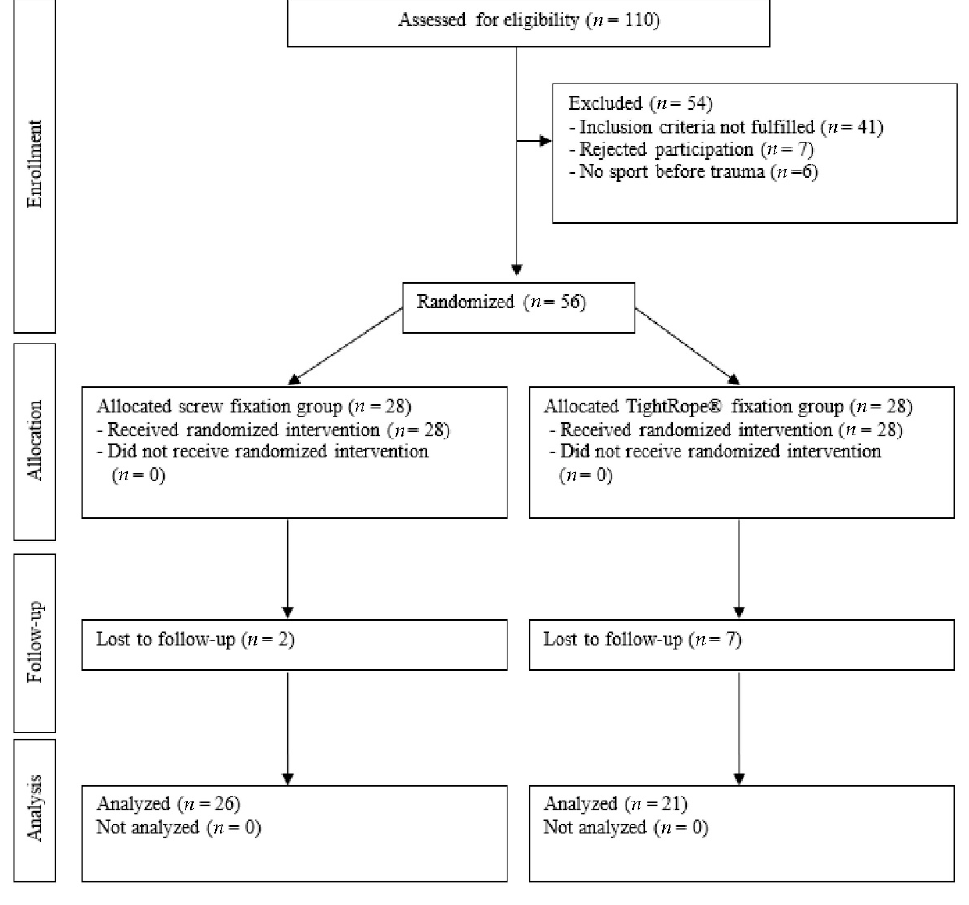
Figure 1. Flow chart for patient selection. The average patient age was 35.5 years (range, 18–60 years). The patient demographics are listed in Table